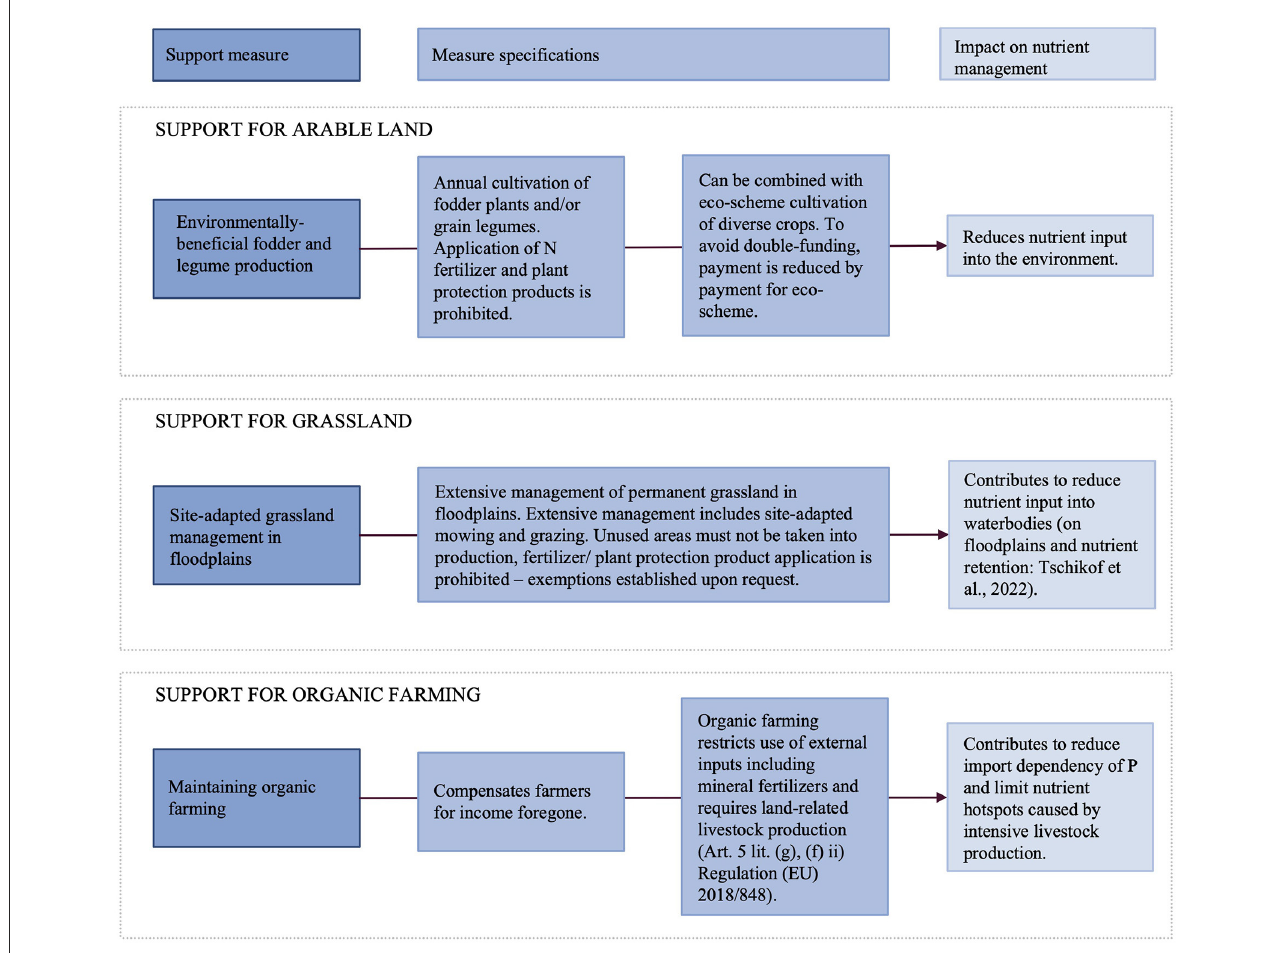
FIGURE1 Agri-environment-climate commitments in Saxony (based on Saxon State Ministry for Energy, 2022a, pp. 7, 26, 42).